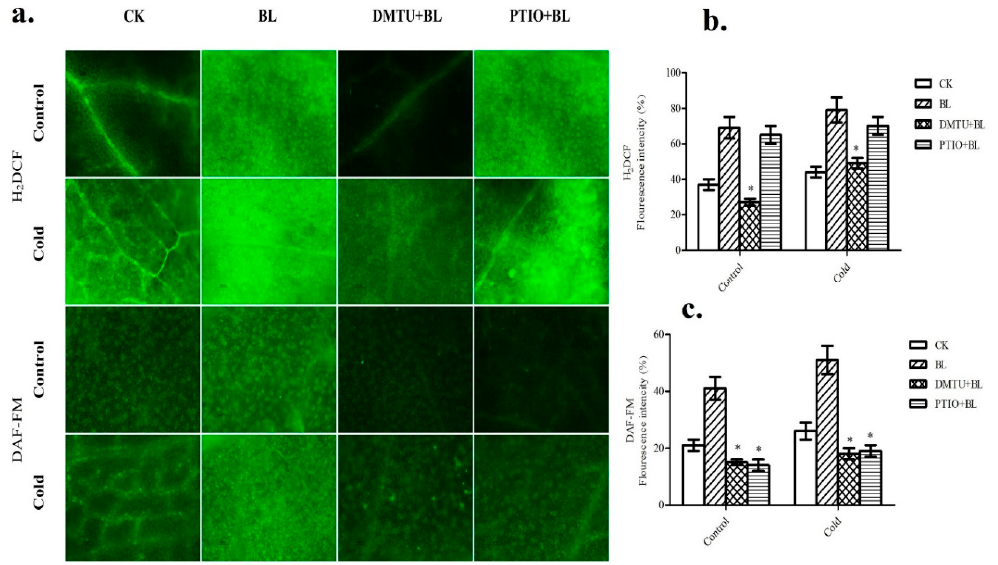
Figure 4. The relationship between BRs-induced H 2 O 2 and NO accumulation under cold stress conditions. Images were taken after 24 h of chemicals treatment using a fluorescence microscope (Scale bars = 75 μ m) ( a ). Quantitative measurements of H 2 O 2 level ( b ) and NO level ( c ) in young leaves. Bars represent mean and standard deviation of values obtained from three biological replicates. Significant differences ( p < 0.05) are denoted by